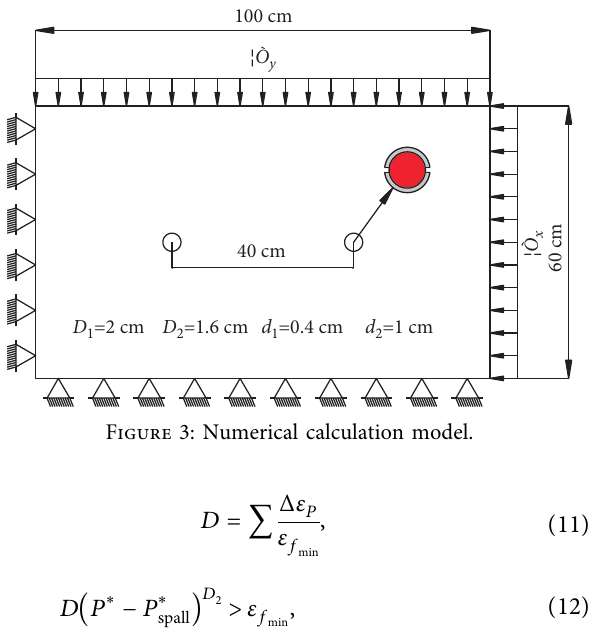
Figure 3: Numerical calculation